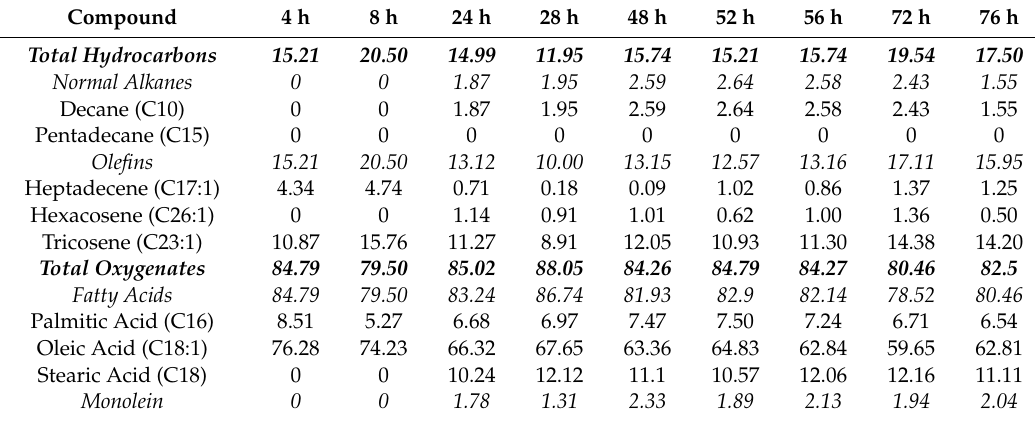
Table A5. GC-MS analysis of product mixtures in the thermal upgrading of yellow grease (75 wt.%